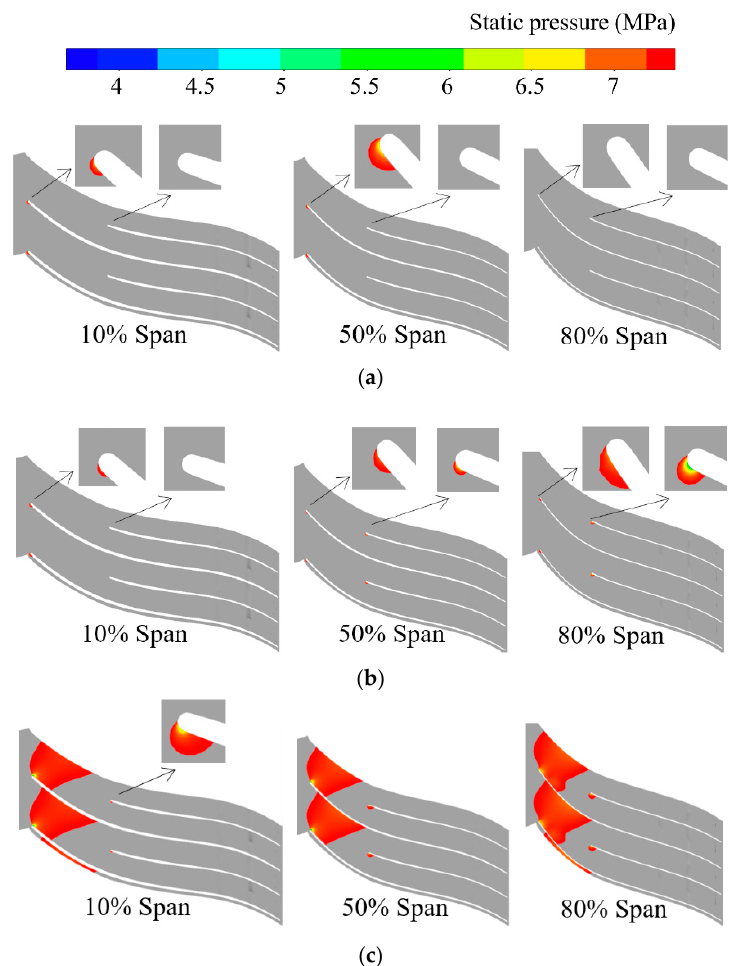
Figure 12. The static pressure contours below the critical pressure of the three operating conditions (3 kg/s, 5 kg/s, and 7 kg/s) at 10%, 50%, and 80% spans: ( a ) 3 kg/s m = ; ( b ) 5 kg/s m = ; and ( c ) 7 kg/s m = .